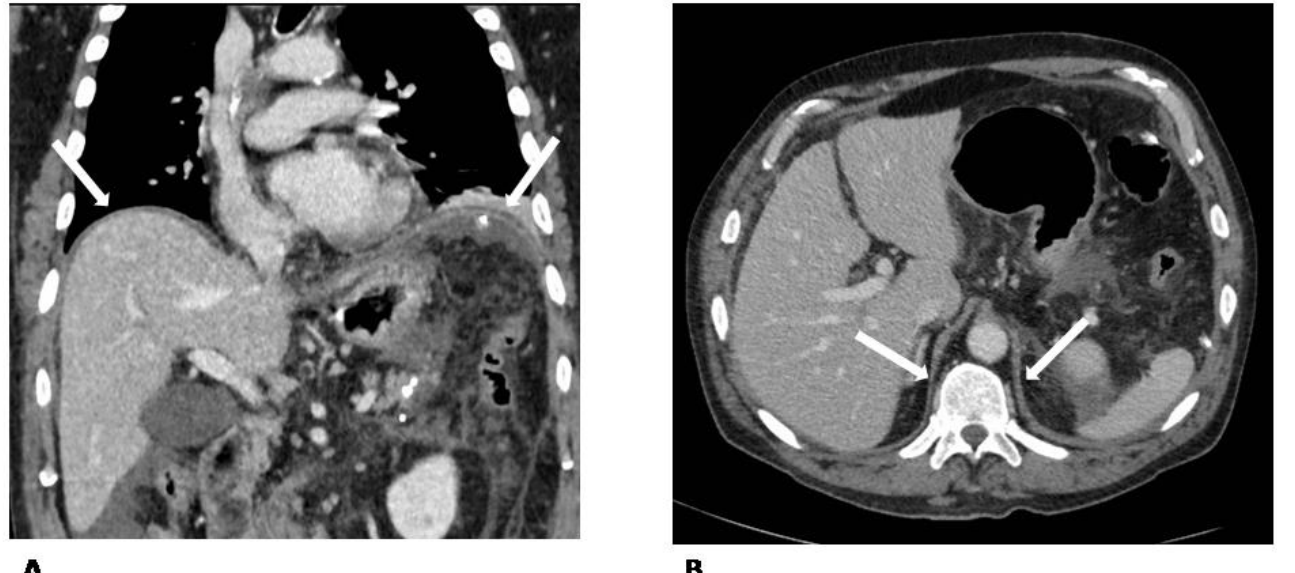
Figure 1. Normal appearance of the diaphragm. The computed tomography scan clearly shows the crura in the direct coronal ( A ) and axial planes ( B ). The normal appearance of the diaphragm, both in the posterior region (crura) at the liver dome level and the left anterior diaphragm (arrows).